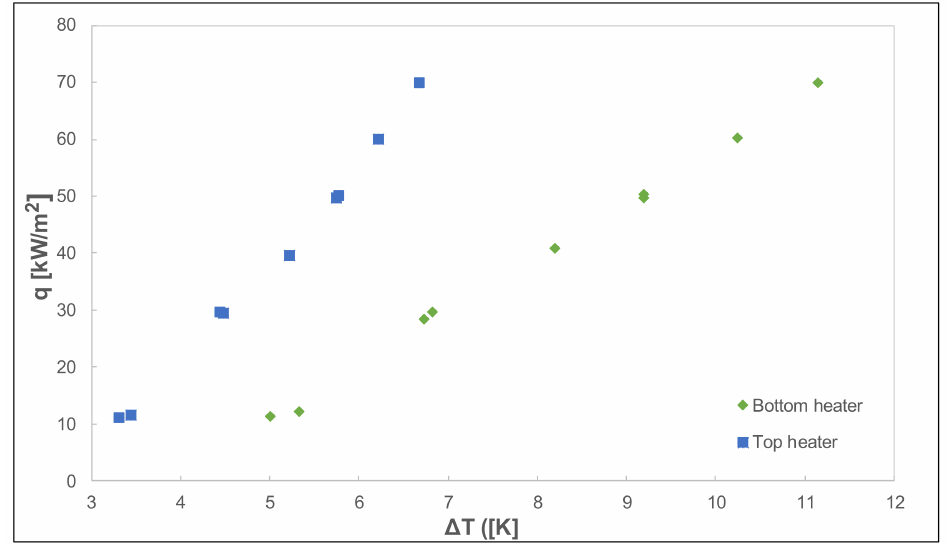
Figure 8. Heat flux vs. temperature difference of heaters and